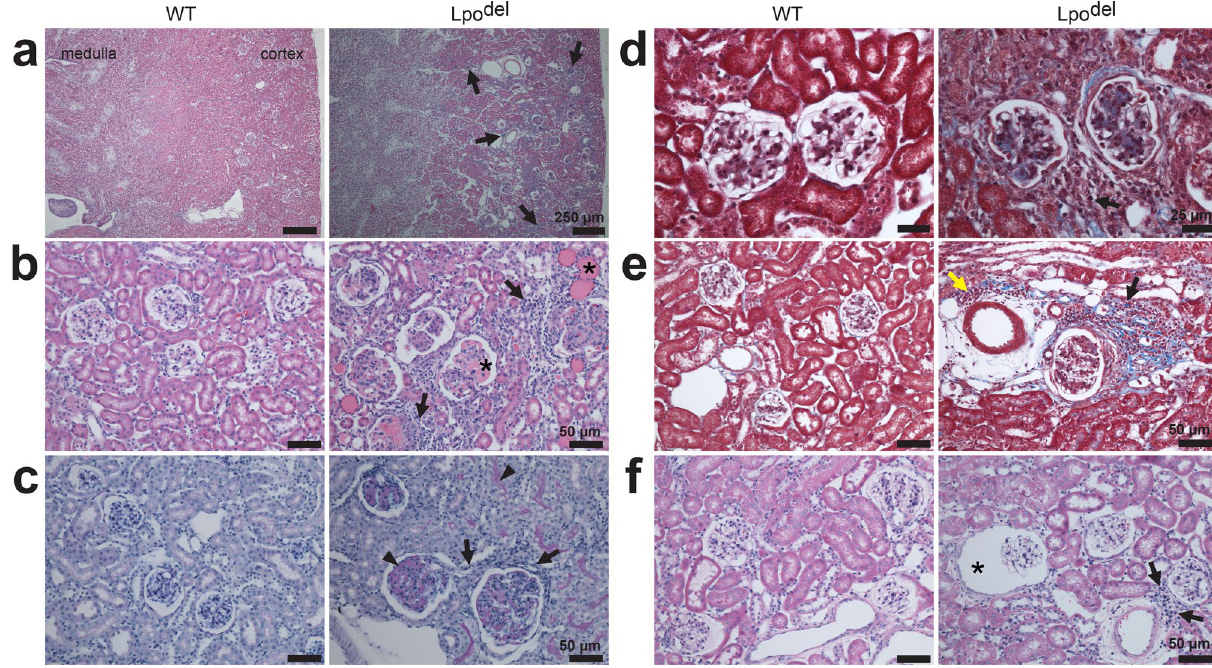
Figure 4. Renal histopathology of Lpo del mice. ( a – f ) Tissue samples showing areas of the renal cortex of wild-type (left) or mutant (right) mice where only samples in ( a ) contained also part of medulla. Sections were stained by HE unless specified otherwise. ( a , b ) Sections where the mutant sample exhibited infiltrating leukocytes (arrows), and eosinophilic proteinaceous material stained pink (asterisks, b ) in or around pathological glomeruli and in adjacent renal tubules. ( c ) PASH-stained sections where the mutant sample exhibited increased glycoproteins (stained purple) in the GBM and the adjacent tubule wall (arrowheads), accompanied by some infiltrating leukocytes (arrows) in the tubulointerstitium. ( d , e ) MT-stained sections where the mutant samples revealed: (i) increased collagen deposition (blue) in or around the pathological glomeruli, or around tubules and the vasculature; (ii) infiltrating mononuclear (black arrows) and scattered polymorphonuclear (yellow arrow, e ) leukocytes in the perivascular space and the tubulointerstitium around the affected glomeruli. ( f ) Sections where the mutant sample exhibited an atrophic glomerulus with enlarged Bowman’s space (asterisk) and a cluster of infiltrating leukocytes (arrows) between a glomerulus and an artery. Scale bars are 25 µm ( d ); 50 µm ( b , c , e , f ); 250 µm ( a Lpo del mice exhibit inflammatory pathology in the digestive system. We examined the small intestines and colon sections of 16 Lpo del mice, and found 9 of them exhibited pathological changes, absent in 18 wild-type mice (Fig. 5). Multifocal infiltration of leukocytes was present in mucosa or submucosa or both layers (Fig. 5c,g; Supplemental Fig. 3j,n). While wild-type samples had sparse normal gut-associated lymphoid tissue (GALT), some mutant samples exhibited numerous larger clusters of leukocytes (arrows, Fig. 5f). In some areas of the mucosal epithelium, there was erosion and sloughing of lining cells (Fig. 5h). In some other areas, intestinal units became disordered or crowded, a term used to capture both villus-crypt units and crypts (cyan arrowheads, Fig. 5e,i). The one-dimensional density of these units in colon, but not in small intestines, increased in mutant samples, compared with those in wild-type samples (Supplementary Fig. S3k,o). Also observed was increased number or size, or both changes, of Paneth cells (blue arrowheads, Fig. 5a,b), mucin-secreting goblet cells (magenta arrowheads, Fig. 5a,d,i), and the granules inside them. Excessive secreted mucus (yellow arrow- heads, Fig. 5d,i) and mucin stored in goblet-cell granules were revealed by alcian blue and PAS that stain acidic and neutral mucin blue and red, respectively; a mixture of them gave an overall purple perception. In mutant small intestines and colon samples, the one-dimensional density of goblet cells was increased (Supplemen- tary Fig. S3l,p). Moreover, heavier collagen deposition stained blue by MT (Fig. 5e,j) or thickened muscularis (Fig. 5a,e), or both changes, appeared in some affected areas; the observed maximum thickness of muscularis within a given field was increased above that of wild-type mice (Supplementary Fig. S3m,q). The above findings are consistent with inflammatory bowel pathology. Similar to the intestines, the stomach also exhibited inflam- matory pathology (Supplementary Fig. S2d). The liver sections from 3 out of 11 wild-type mice are marked positive for the presence of some sparse leuko- cytes (Fig. 1h). In contrast, in the sections from 10 out of 13 Lpo del mice, we observed the following remarkable inflammatory pathology (Fig. 6a–d). Multifocal infiltration of leukocytes and degenerative hepatocytes were present in the parenchyma (Fig. 6a), or in and around the wall of blood vessels (Fig. 6b). The "bump" in the ves- sel pointed at by black arrow contained infiltrating leukocytes, fibrogenic cells lightly stained by MT, and darker stained collagen, which is reminiscent of a pre-thrombosis condition. The number of leukocytes and the level of collagen deposition were greater in mutant samples than in wild-type samples (Supplementary Fig. S3r,s).